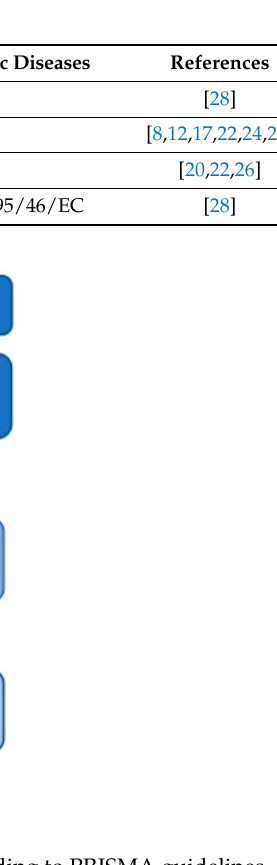
Figure 1. Flow diagram of identified and included records, according to PRISMA guidelines. Table 1. Overview of the results—barriers. Barriers to eHealth and mHealth